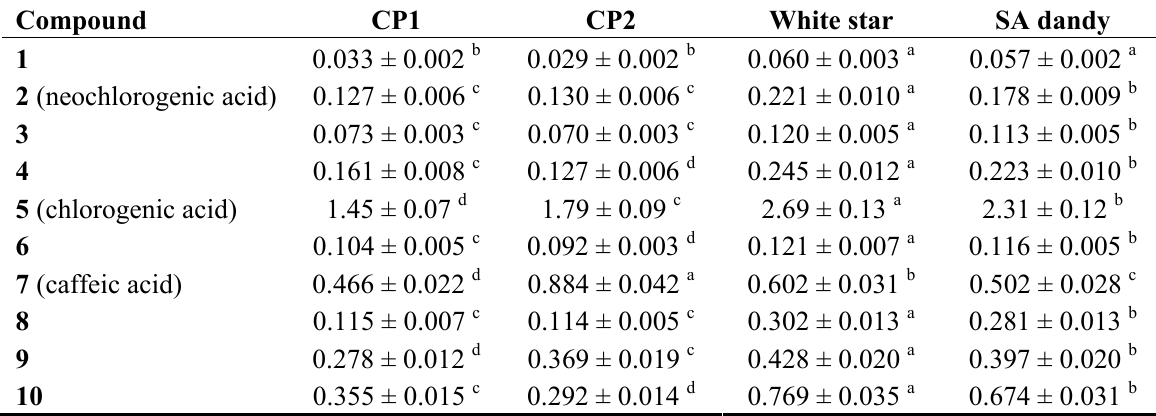
Table 2. Content of individual phenolic compounds in the extracts